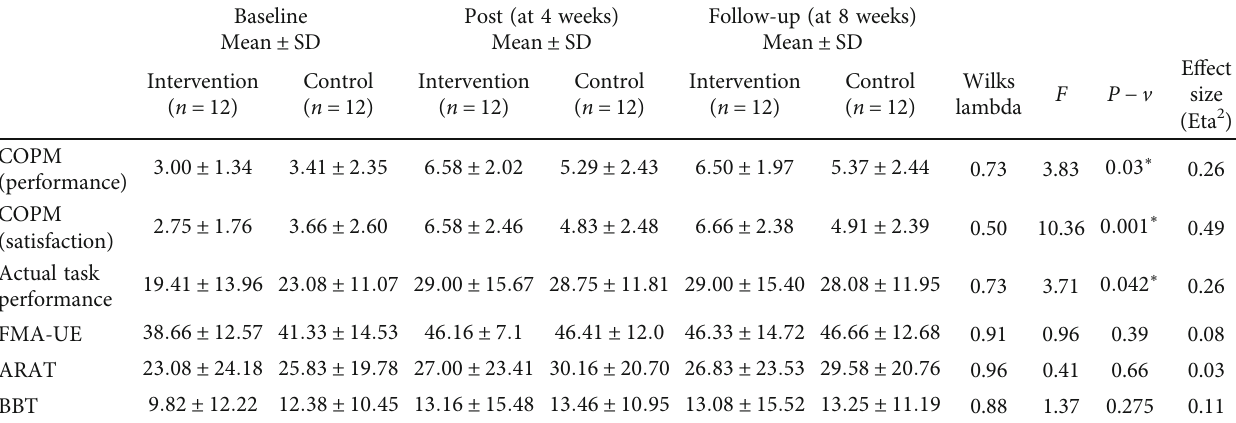
Table 3: Pre, post, and follow-up outcome measures of the intervention and control groups (time × group interaction). Baseline Post (at 4